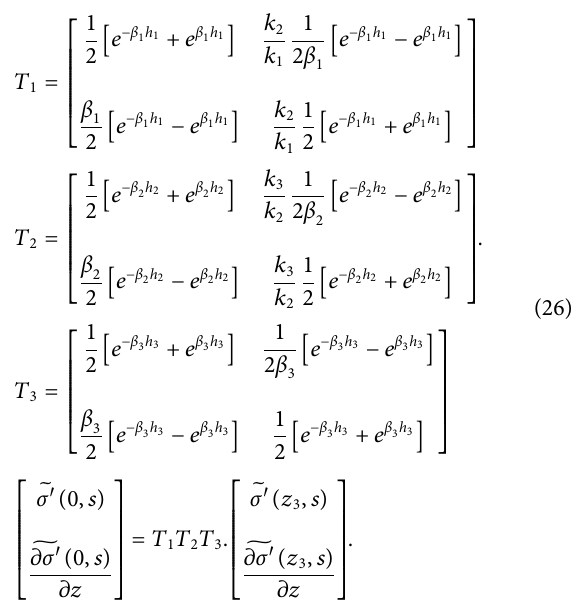
FIGURE 6 | Plot of consolidation coef fi cient c v versus time. FIGURE 7 | Overpressure evolution comparison between the two upscaling methods (weighted average and the new method) and numerical results for 10, 100, 1,000, and 10,000 days.